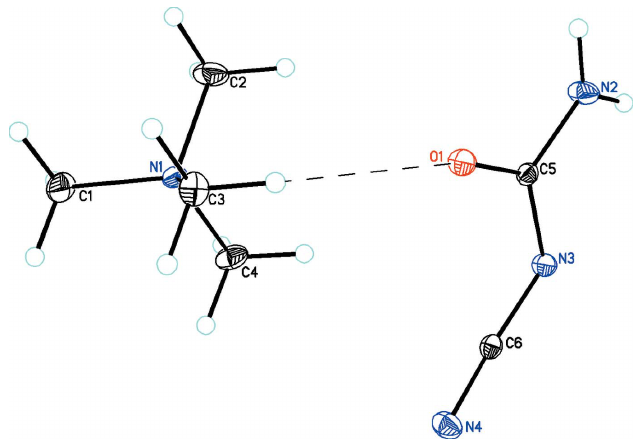
Figure 1 Diagram showing the [C 4 H 12 N] + cation and [C 2 H 2 N 3 O 3 ] (cid:3) anion linked by a C—H (cid:2)(cid:2)(cid:2) O interaction (shown as a dashed line). Atomic displacement parameters are drawn at the 30% probability level.